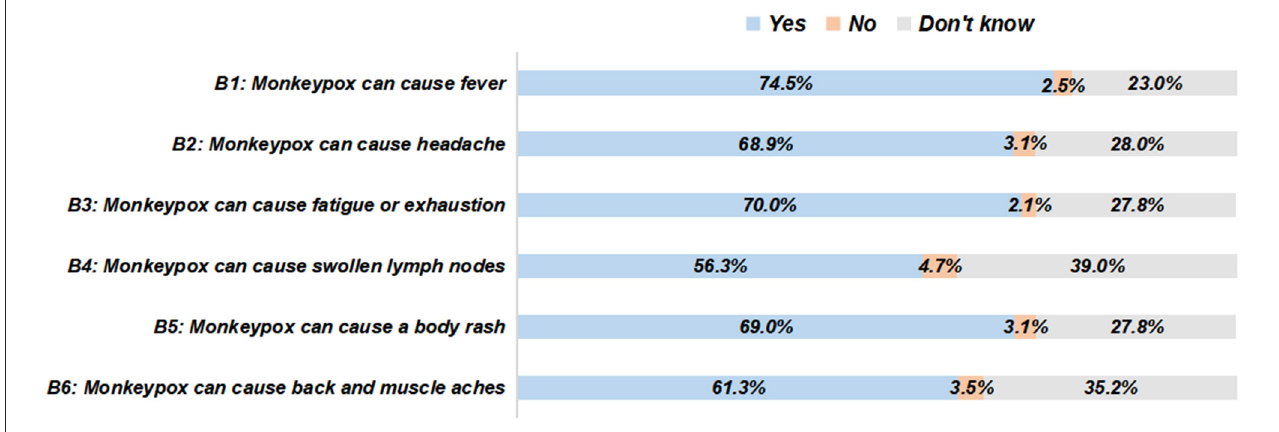
FIGURE3 The responses to specific knowledge items of mpox-related symptoms among people who were aware of mpox ( N =